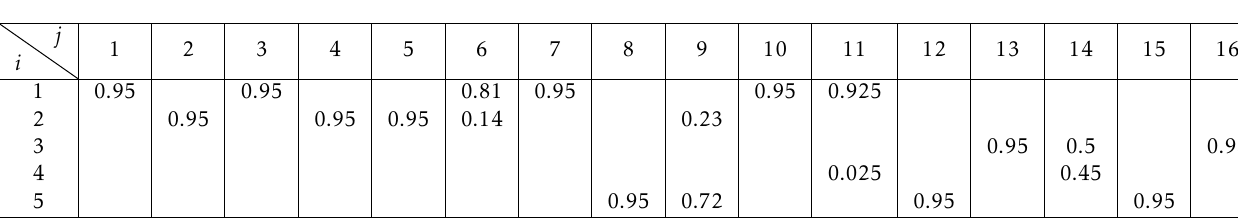
Table 2. Coverage per